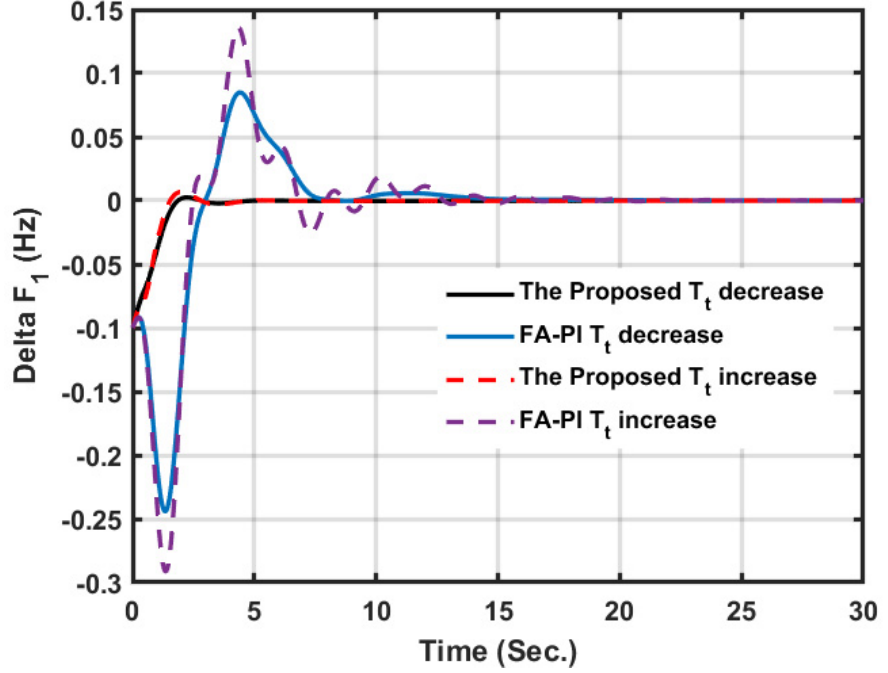
Figure 25. Frequency deviation in area 1 under T t changes.